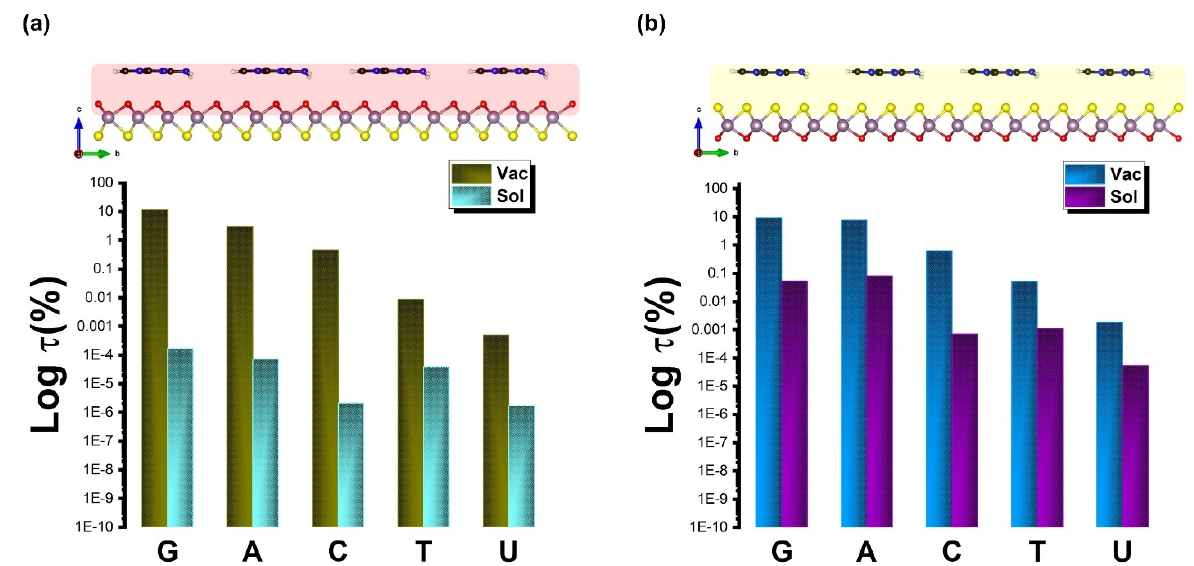
Figure 8. The recovery time of the nucleobases molecules on the Janus MoOS monolayer facets at T = 298 K, ( a ) on O layer, ( b ) on S layer, respectively.